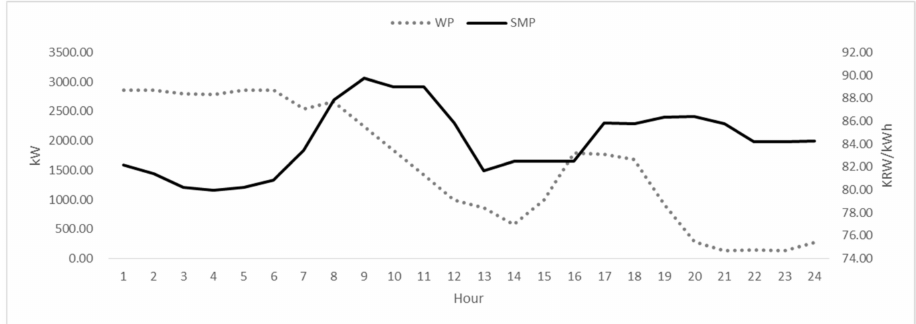
Figure 8. Wind power metered with hourly granularity and pattern of the SMP on 11 March